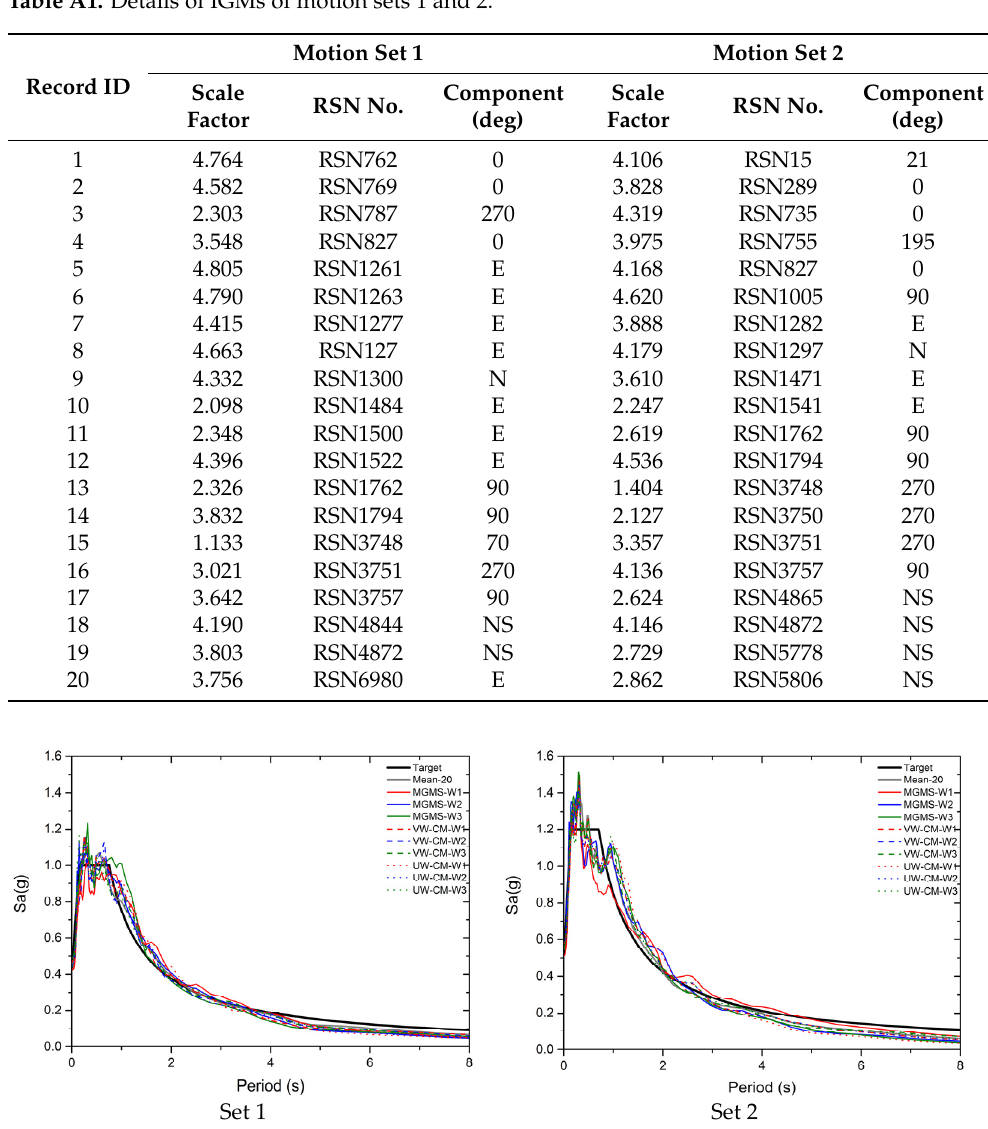
Table A1. Details of IGMs of motion sets 1 and 2.